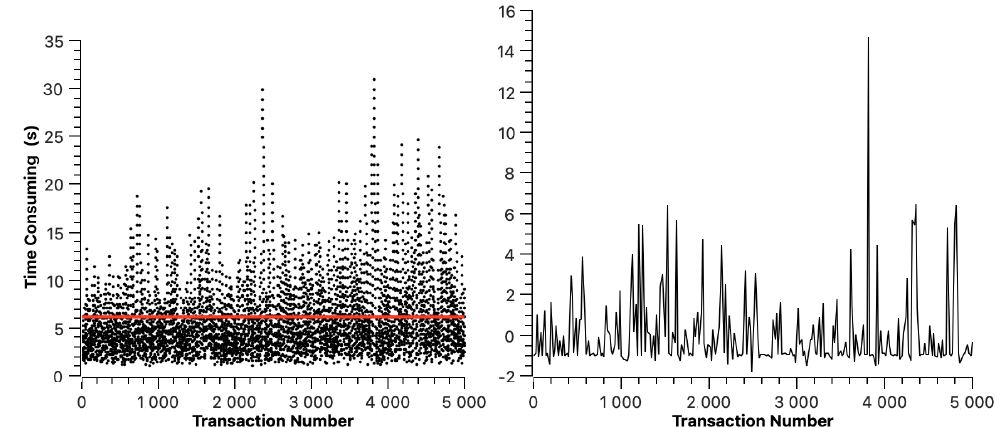
Figure 5. Ethereum cross-chain transaction resolution